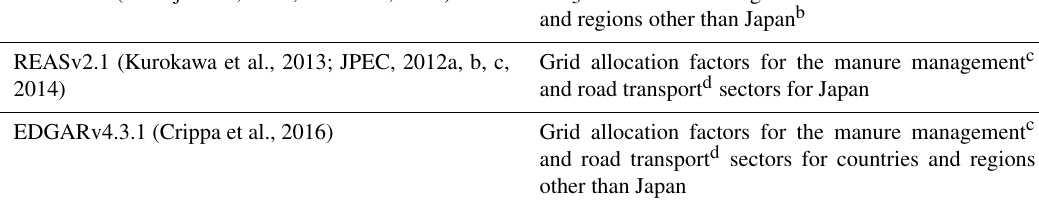
Table 2. Emission inventories from other research works and officially opened data utilized in REASv3. Other emission inventories and data sources How utilized in REASv3 VOC Emission Inventory in Japan (MOEJ, 2017) Evaporative emissions of NMVOCs in Japan a The National Air Pollutants Emission Service of the National Institute of Environmental Research (https: